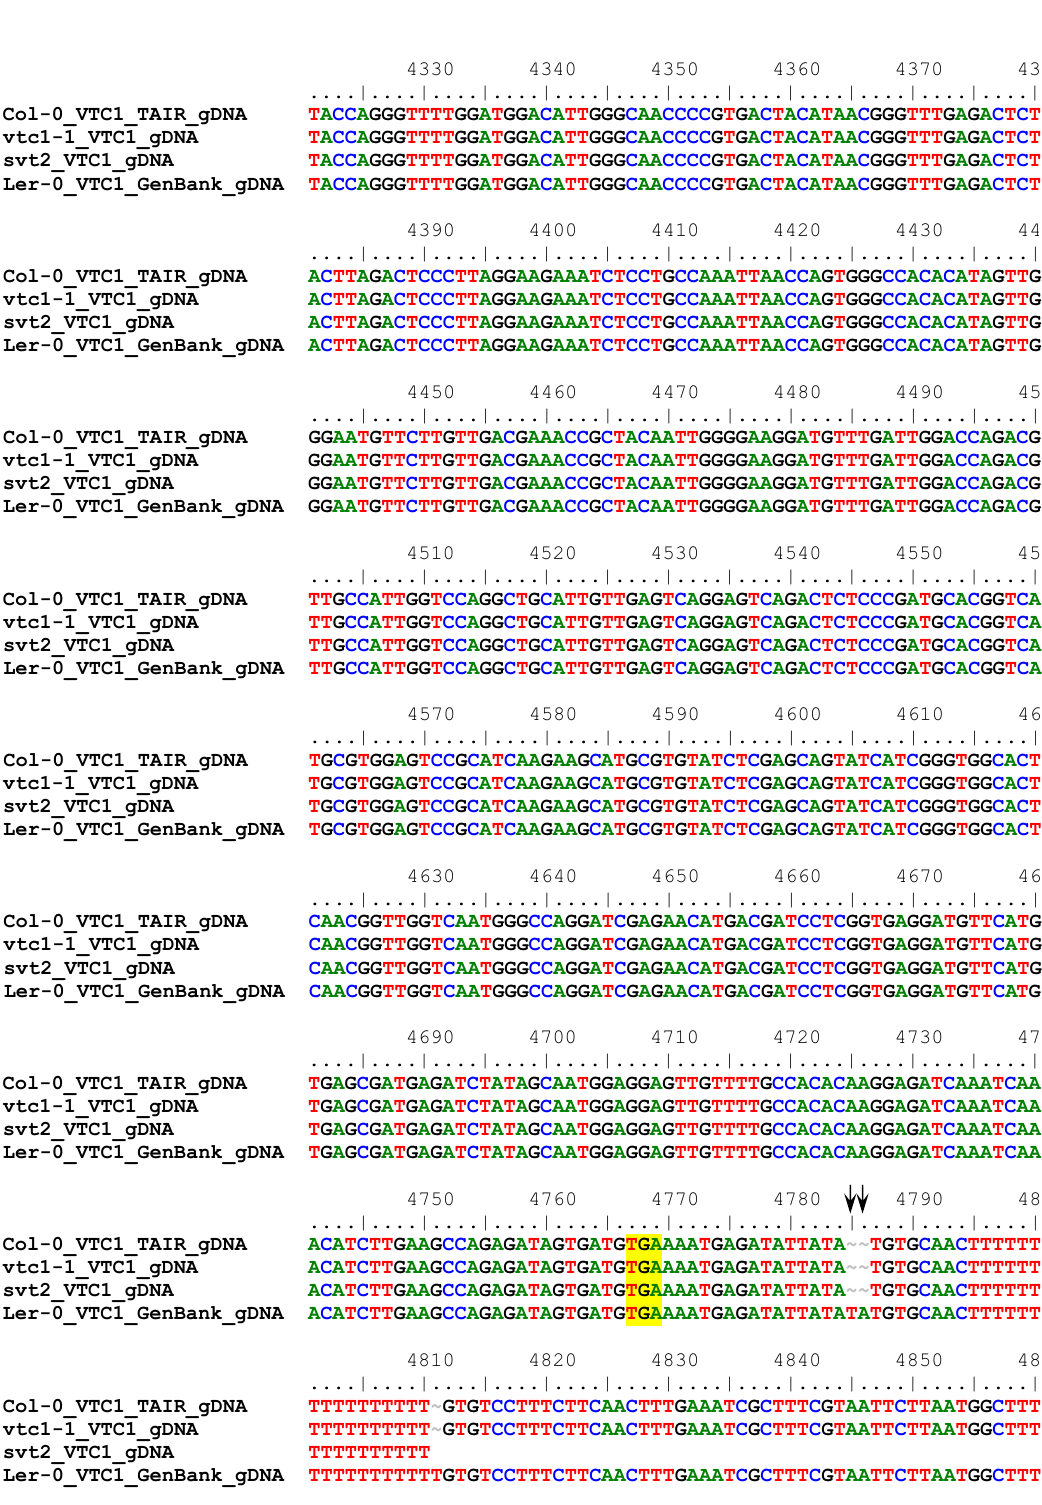
Figure S1. Sequence alignment of the VTC1 gene sequence of the Col-0 TAIR database, the vtc1-1 , svt2 mutants, and the L er -0 GenBank database. Horizontal arrows denote 5´ respectively 3´ flanking regions of the sequence insertion, which is highlighted in grey, in the VTC1 promoter region (between base pairs 1990 and 2273). Upright arrows indicate sequences shared between svt2 and Ler. Arrows pointing down denote sequences shared between svt2 and Col. Arrowheads point to sequences unique to svt2. Highlighted in yellow are the start and stop codons, respectively. Highlighted in green is the vtc1-1 mutation